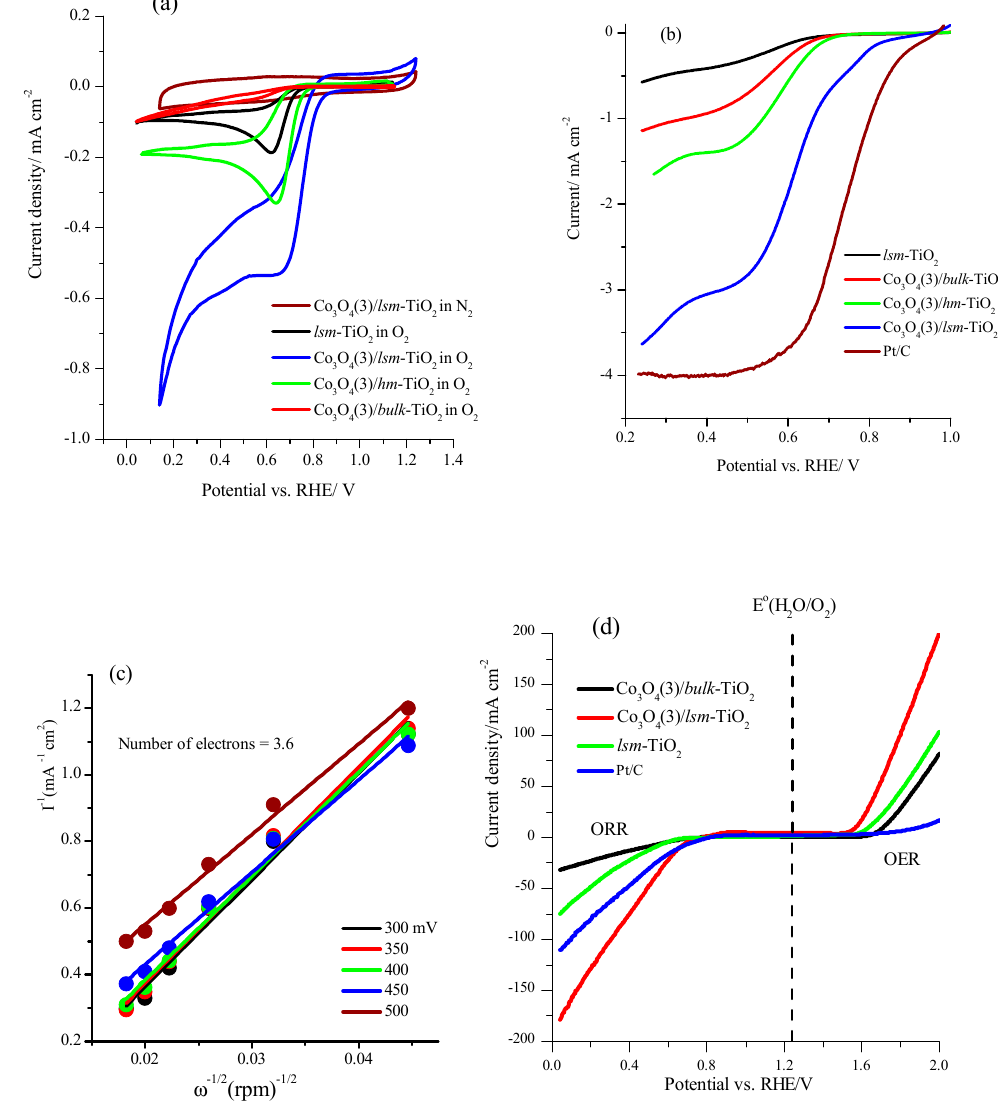
Figure 8. ( a ) Cathodic-going LSV curves at 10 mV s -1 of lsm -TiO 2 and Co 3 O 4 (3) / lsm -TiO 2 catalysts loaded on GC electrode in N 2 - and O 2 -saturated 1.0 M of KOH solution; ( b ) the LSV plots of lsm -TiO 2 , Co 3 O 4 (3) / bulk -TiO 2 , Co 3 O 4 (3) / hm -TiO 2 , and Co 3 O 4 (3) / lsm -TiO 2 , loaded on GC electrode at a scan rate of 10 mV s − 1 and a rotation speed of 2000 rpm in 1.0 M KOH solution; ( c ) the corresponding Koutecky–Levich (K–L) plots (at potentials of 0.25–0.5 V vs. RHE) for Co 3 O 4 (3) / lsm -TiO 2 catalyst; ( d ) the LSV of both OER and ORR at scan rate of 10 mV s − 1 of lsm -TiO 2 , Co 3 O 4 (3) / lsm -TiO 2 , Co 3 O 4 (3) / bulk -TiO 2 , and Pt / C catalysts supported on CP electrode in O 2 -saturated 1.0 M KOH solution (the catalyst loading on the CP electrode was 0.8 mg cm − 2 for all catalysts).